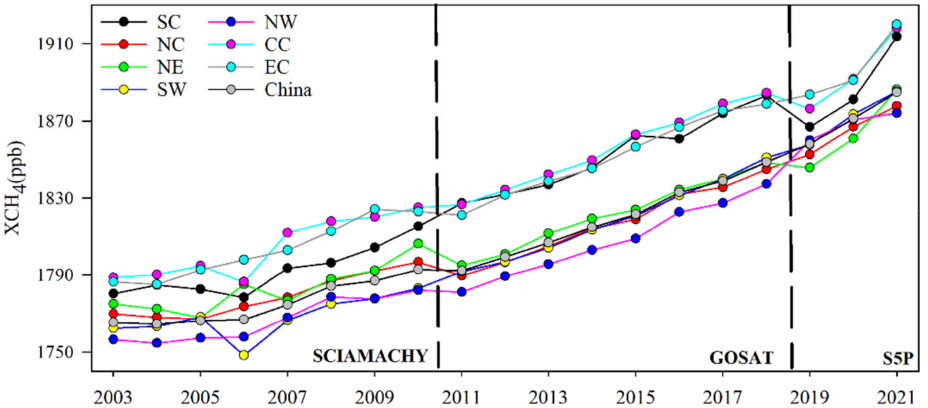
Figure 6. Annual averages of XCH 4 concentrations in the seven regions and China overall from 2003 to